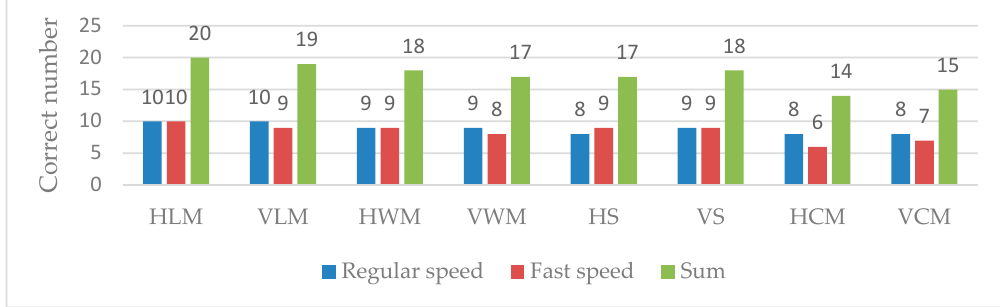
Figure 12. The correct recognition number of GLR-DTW.